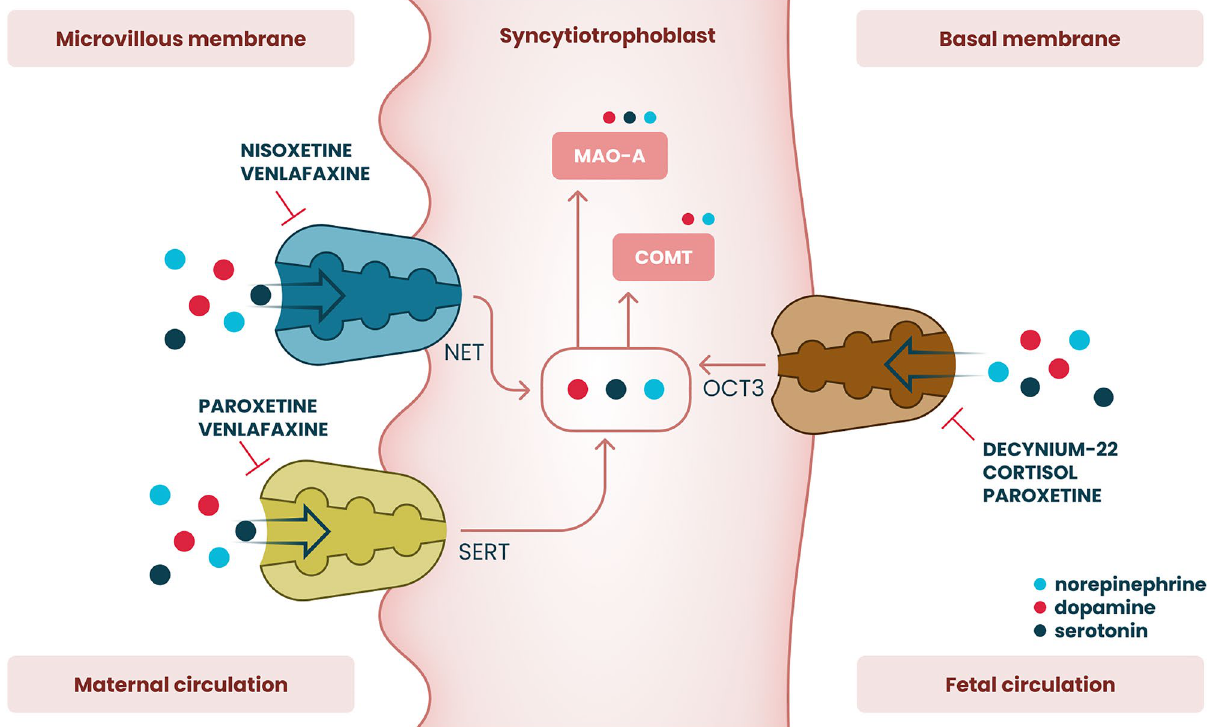
Figure 6. Summary of monoamine transport mechanisms in the apical and basal membranes of the human placental syncytiotrophoblast. Active uptake of dopamine and norepinephrine by the microvillous membrane is mediated via the high-affinity and low-capacity serotonin (SERT/SLC6A4) and norepinephrine (NET/SLC6A2) transporters. On the other hand, the organic cation transporter 3 (OCT3/SLC22A3) contributes to the placental monoamine clearance system by effectively mediating dopamine and norepinephrine uptake from the fetal circulation across the basal